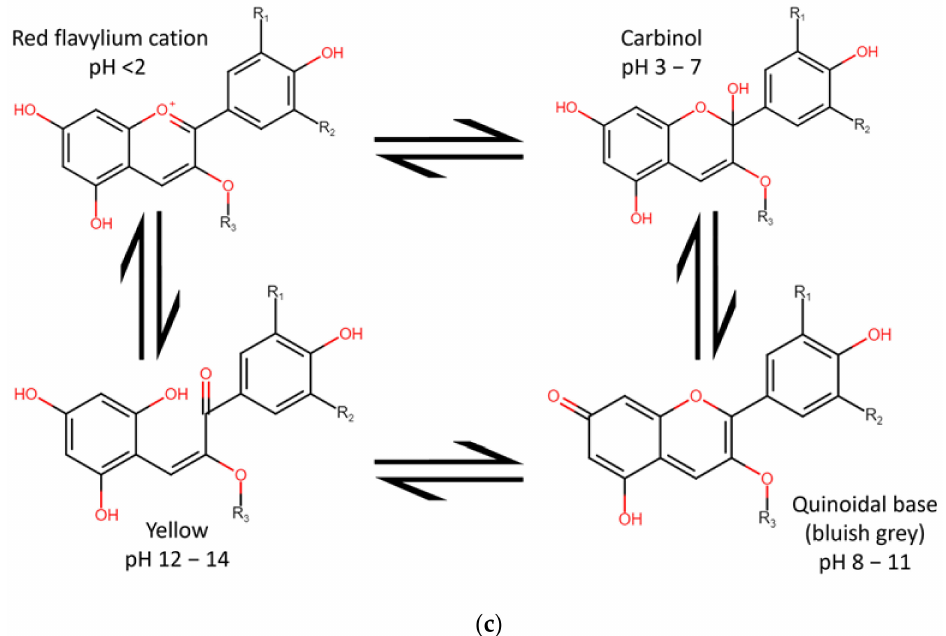
Figure 2. ( a ) UV-Vis spectra of anthocyanin extract in different pH buffers, ( b ) color variation of anthocyanin in different pH, and ( c ) structural transformation of anthocyanin in